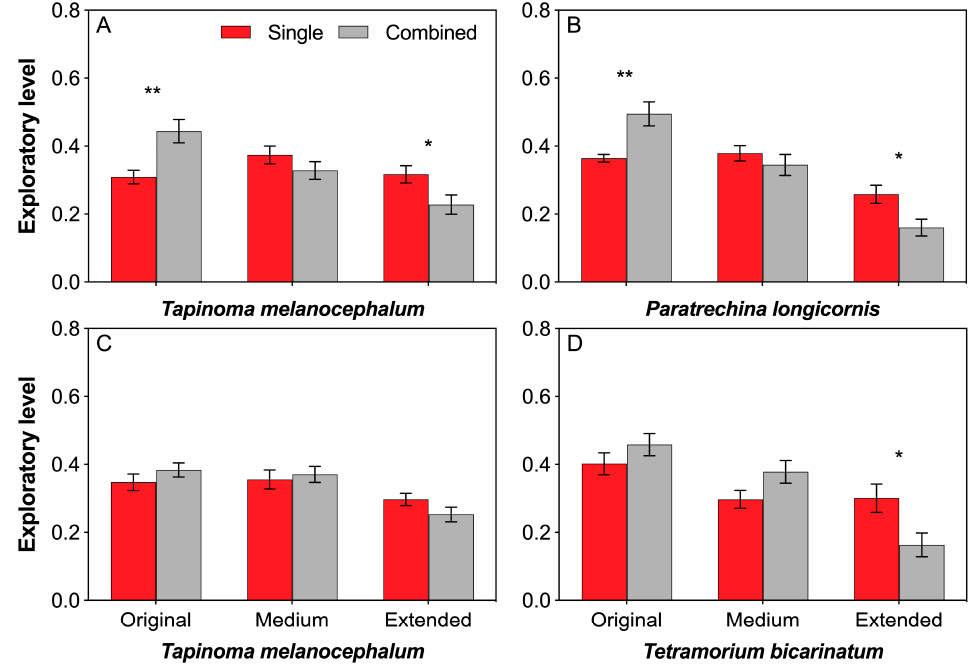
Figure 6. Effects of interference competition on ant exploratory level. ( A , B ) T. melanocephalum - P. longicornis interaction, ( A ) exploratory level of T. melanocephalum ; ( B ) exploratory level of P. longicornis . ( C , D ) T. melanocephalum - T. bicarinatum interaction, ( C ) exploratory level of T. melanocephalum ; ( D ) exploratory level of T. bicarinatum. The data are presented as the mean ± SE. Asterisk (* or **) on bars indicates significant differences between the treatments ( P < 0.05 or P < 0.01).